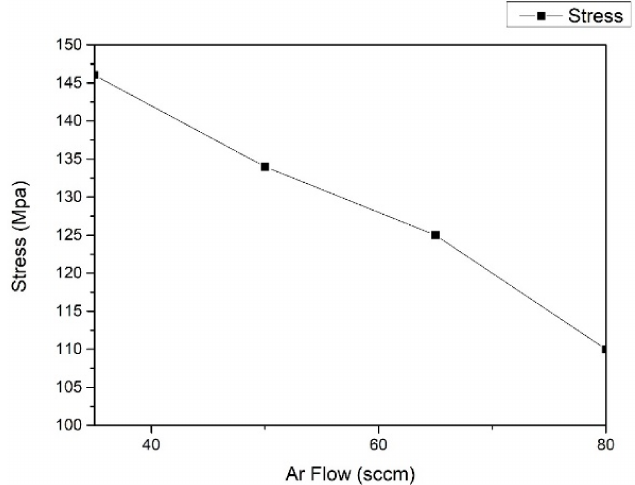
Figure 6. Nb 2 O 5 /SiO 2 multilayer thin-film stress